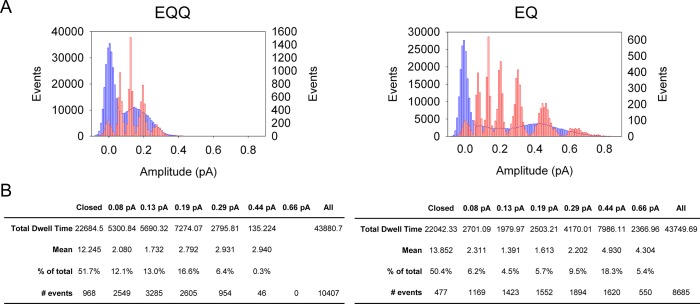
Subconductance analysis of EQQ and EQ demonstrates that as the number of KCNE1 subunits decreases so does higher conductance state occupancy.(A) All-points amplitude histograms, filtered at 200 Hz, from 11 active sweeps of EQQ (left) and EQ (right) are plotted in blue with idealized histograms of the same data superimposed in red. The left axis represents number of events for the all-points amplitude histogram and right axis for the idealized histogram. Events were idealized using six separate thresholds (0.08, 0.13, 0.19, 0.29, 0.44 and 0.66 pA) as indicated in the tables below and are set based on our earlier work (Werry et al., 2013) and the 3/2 rule for subconductance behavior (Pollard et al., 1994). (B) Total and average dwell times (ms) in each sublevel were calculated as well as the percent dwell time and event numbers. The mean dwell time from the closed state does not include the first latency.